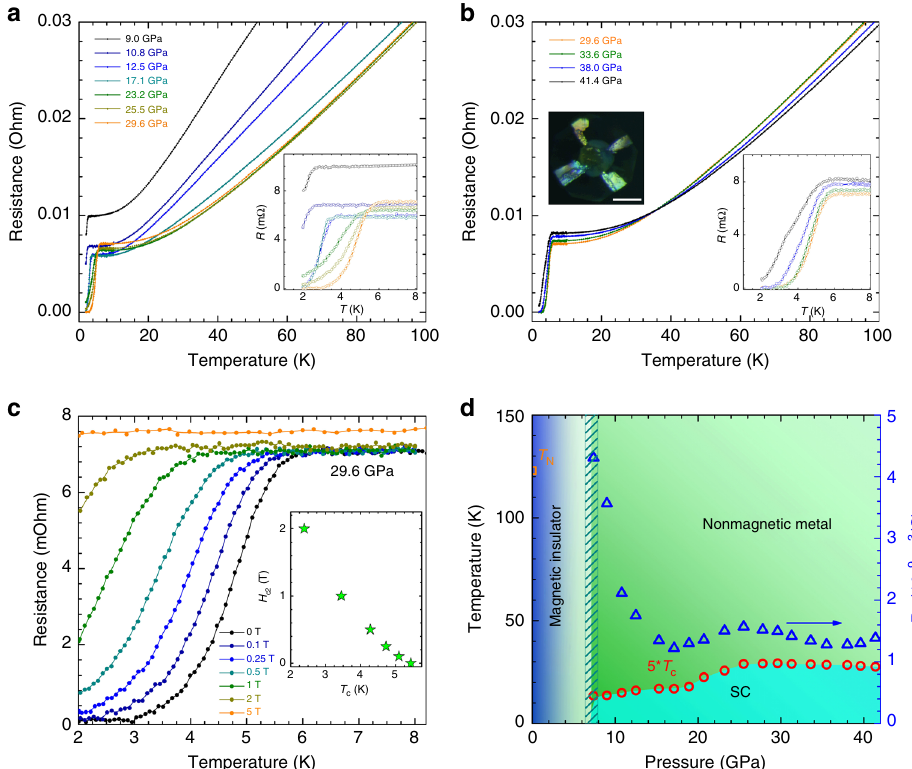
Fig. 4 Emergence of superconductivity under high pressure and temperature – pressure phase diagram in FePSe 3 . a The in-plane electrical resistivity of FePSe 3 single crystal as a function of temperature, and applied pressures 9.0, 10.8, 12.5, 17.1, 23.2, 25.5, and 29.6 GPa. b The in-plane electrical resistivity of FePSe 3 single crystal as a function of temperature, and applied pressures 29.6, 33.6, 38.0, and 41.4 GPa. Insets of a , b show the enlarged low-temperature parts of the measured resistivity. Line colors are the same as those used in a , b . Inset of b shows the photograph of a single-crystal FePSe 3 inside a DAC for resistivity measurements. The scale bar is 100 μ m. c The temperature dependence of the electrical resistivity of FePSe 3 at 29.6 GPa under magnetic fi elds of 0, 0.1, 0.25, 0.5, 1, 2, and 5 T. Inset shows the fi eld dependence of T c for FePSe 3 at 29.6 GPa. d Temperature – pressure phase diagram of FePSe 3 , where solid circles represent the pressure dependence of the onset superconducting transition temperatures (5* T c ), and the blue triangles represent the pressure dependence of Hall coef fi cient. T N represents the Neel temperature of FePSe